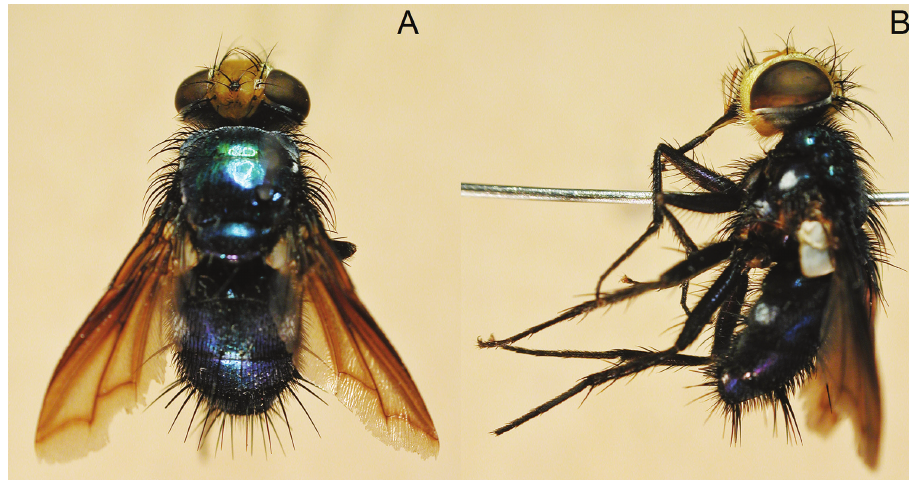
Figure 8. Silbomyia hoeneana Enderlein, ♂ . A dorsal view B lateral costa black, with brown pubescence; subcostal sclerite dark brown; node of R and 2+3 R veins with several black setulae extending to R above and below; vein M 4+5 4+5 1+2 forming right angle; Cell R open at wing margin; section of vein M from bend to 5 1+2 wing margin slightly curved inward; alar squama whitish, with pale yellow edge and white fringe; thoracic squama whitish, bare on dorsal surface, with dark brown edge and dark brown fringe. Halter fuscous, darkened on apex. Legs: Femora dark brown to blackish, with metallic violet tinge; tibiae brown; tarsi dark brown; coxa dark brown to blackish, covered with black hairs and bristles anteri- orly; fore tibia with row of several strong ad , 3 short pd , 2–3 strong p ; mid tibia with row of several strong ad , several short pd , 2–3 strong p , 1 strong av ; hind tibia with 2 av , row of several strong ad , 4 long pd .